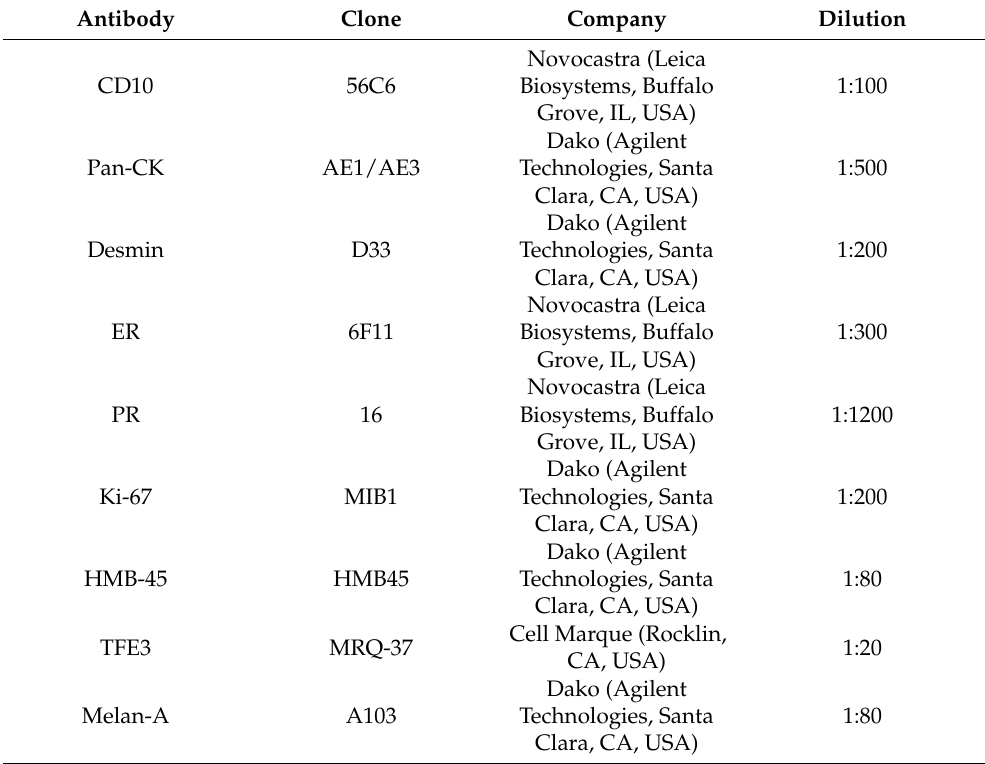
Table 1. Antibodies